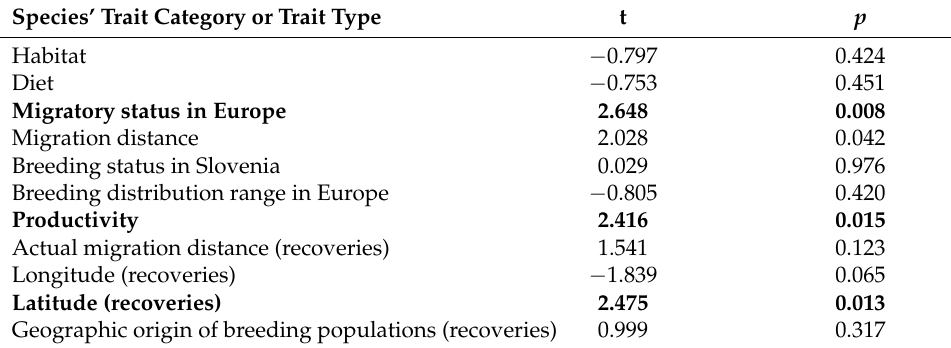
Table 4. Impacts of particular trait on population trend. Bolded are interactions with p >